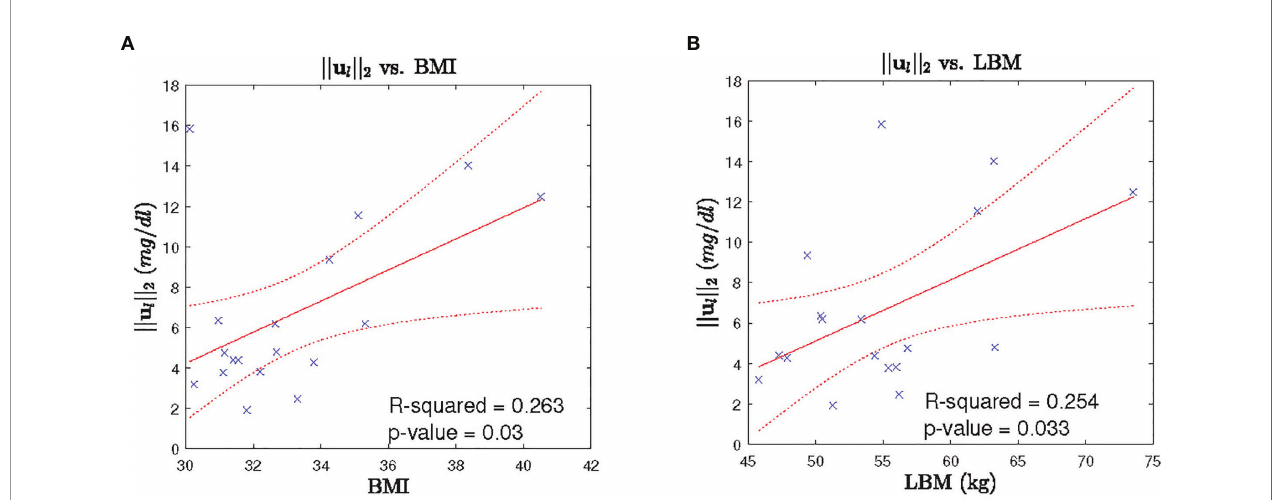
FIGURE 7 | Leptin Secretion Characteristics vs. BMI/LBM. Each panel shows: (A) the scatter plot (blue cross) of BMI vs l 2 -norm of leptin secretion u 2 , fi tted regression line (red solid line), corresponding 95% con fi dence interval (dotted red curve), (B) the scatter plot (blue cross) of LBM vs l 2 -norm of leptin secretion u 1 , fi tted regression line (red solid line), corresponding 95% con fi dence interval (dotted red